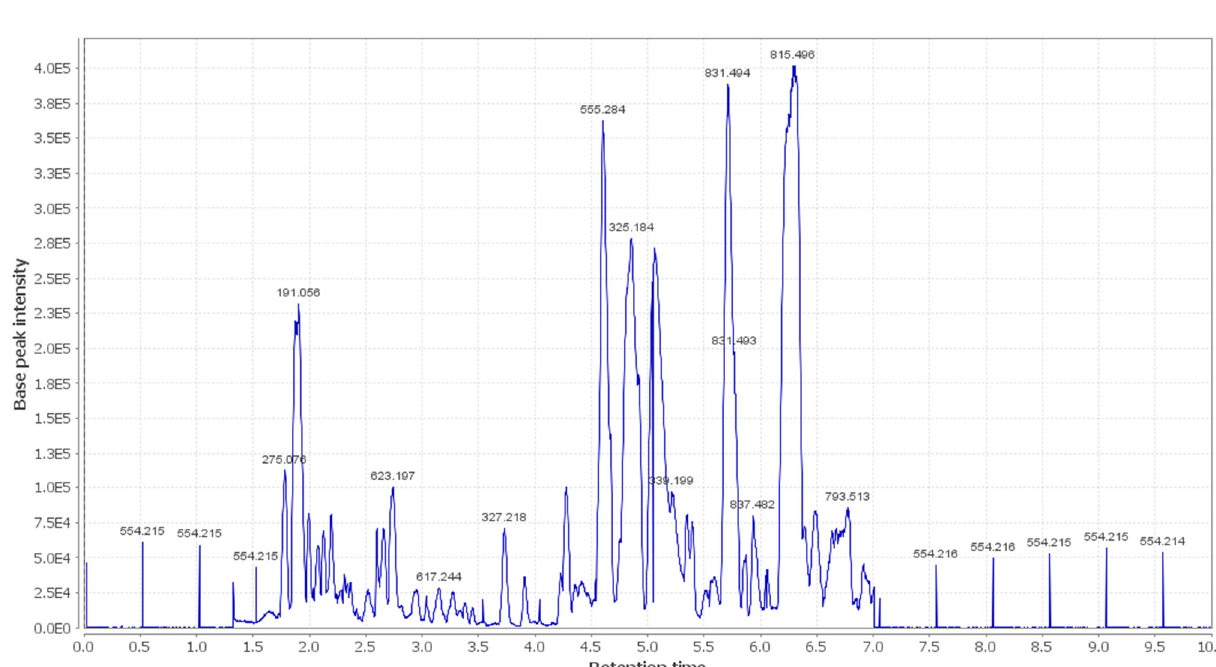
Figure 3. LC-HRESIMS chromatogram of the dereplicated metabolites of OEA (negative mode).